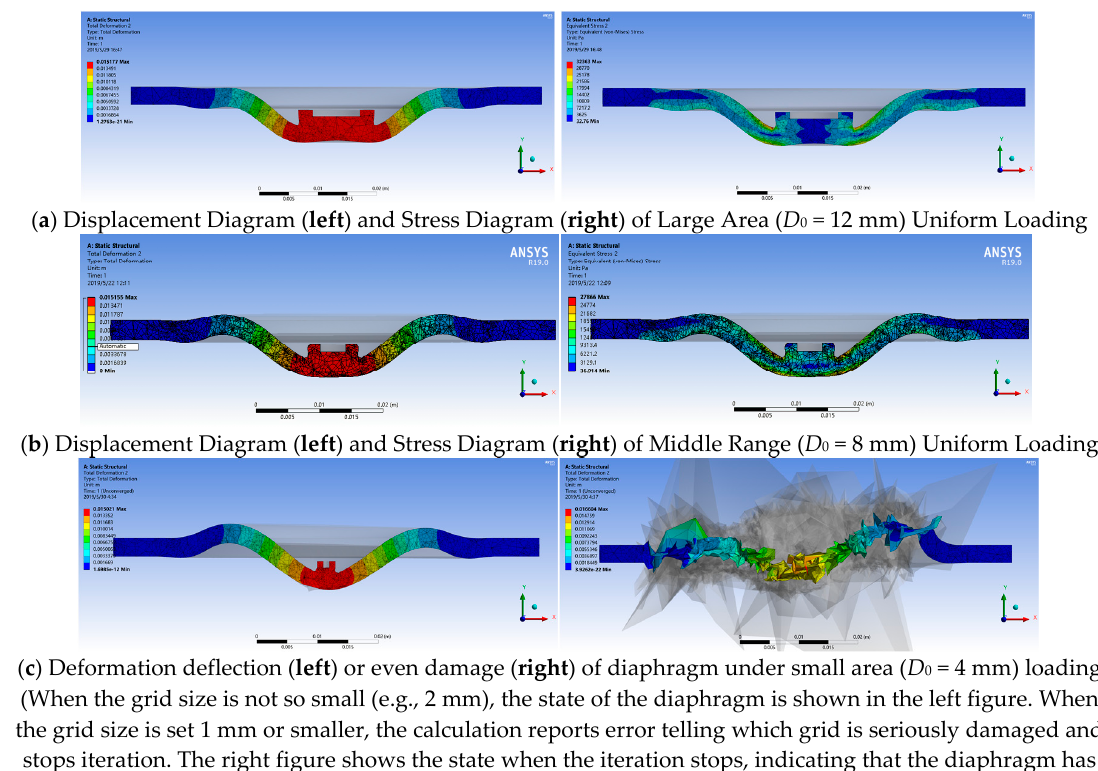
Figure 4. Diaphragm Deformation under Di ff erent Loading Area.